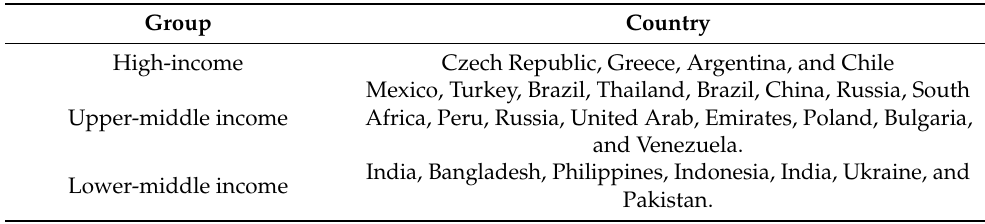
Table 1. Classification of emerging